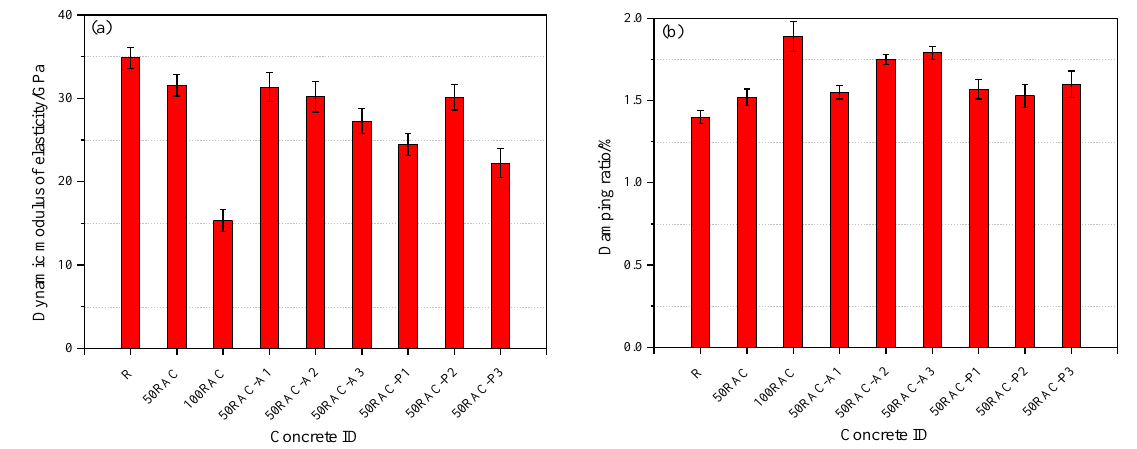
Figure 8. Dynamic behavior of the reference concrete and RAC modified with AGA and PP: ( a ) dynamic modulus of elasticity and ( b ) damping ratio.